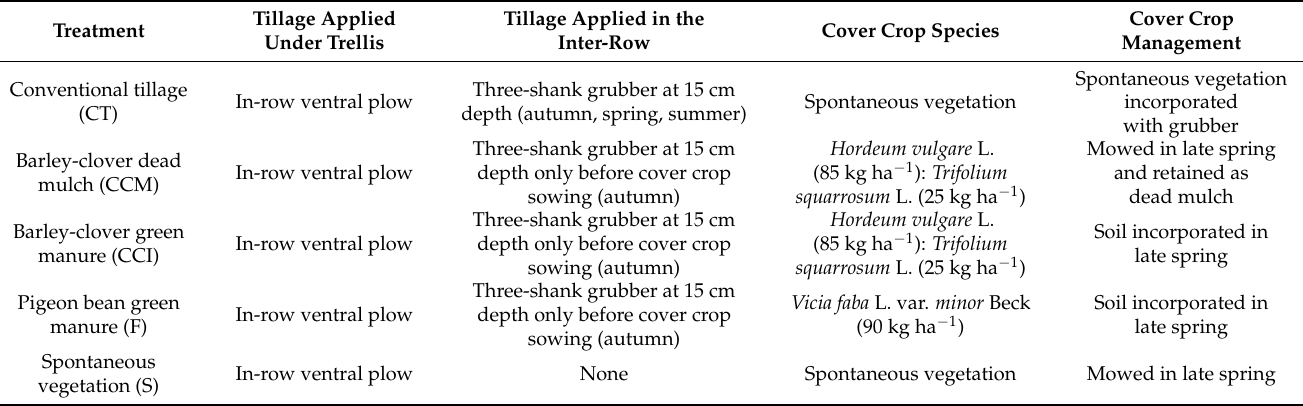
Table 1. Description of the experimental treatments.